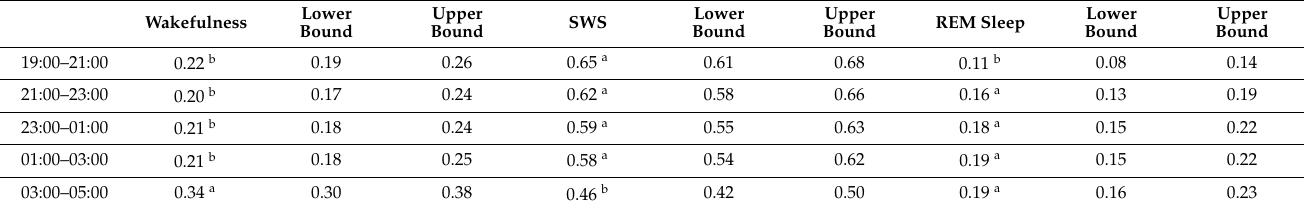
Table 6. Effects during lights off of time interval on proportions of states (wakefulness, slow-wave sleep (SWS) and rapid eye movement (REM) sleep). Values are back-transformed means, with back- transformed mean − SE and back-transformed mean + SE forming the lower and upper bounds, respectively, estimated from LMMs fitted to angular transformed proportions. Where superscripts are different within a column, means are significantly different ( p < 0.05) (obtained through post hoc Tukey’s HSD